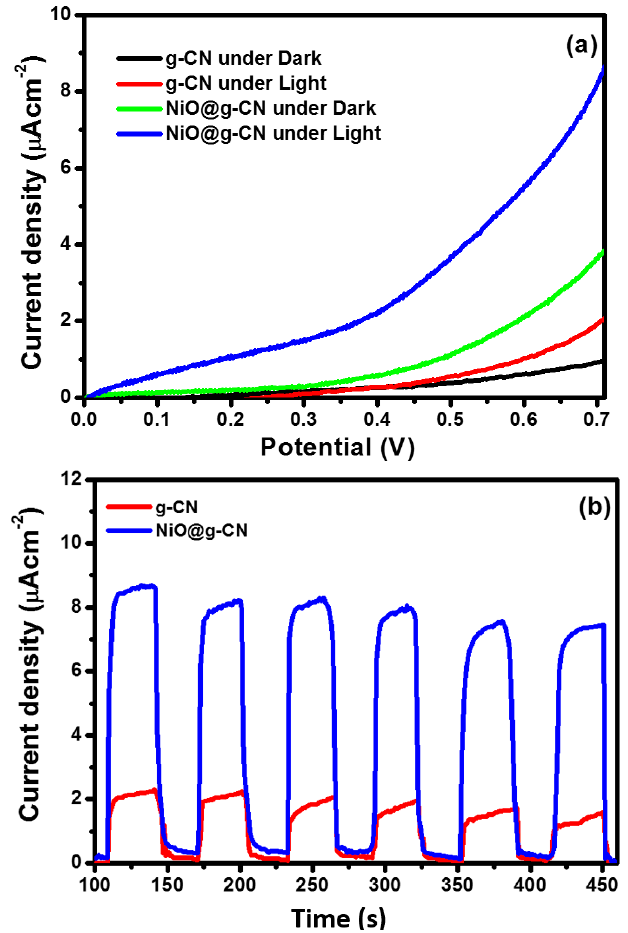
Figure 8. Linear-sweep voltammetric response of g-CN and NiO@g-CN nanocomposite photoanodes under dark and visible-light irradiation ( a ). Chronoamperometric photocurrent–time responses of g-CN and NiO@g-CN nanocomposite photoanodes under periodically chopped visible-light irradiations (light on/off cycle) ( b ).